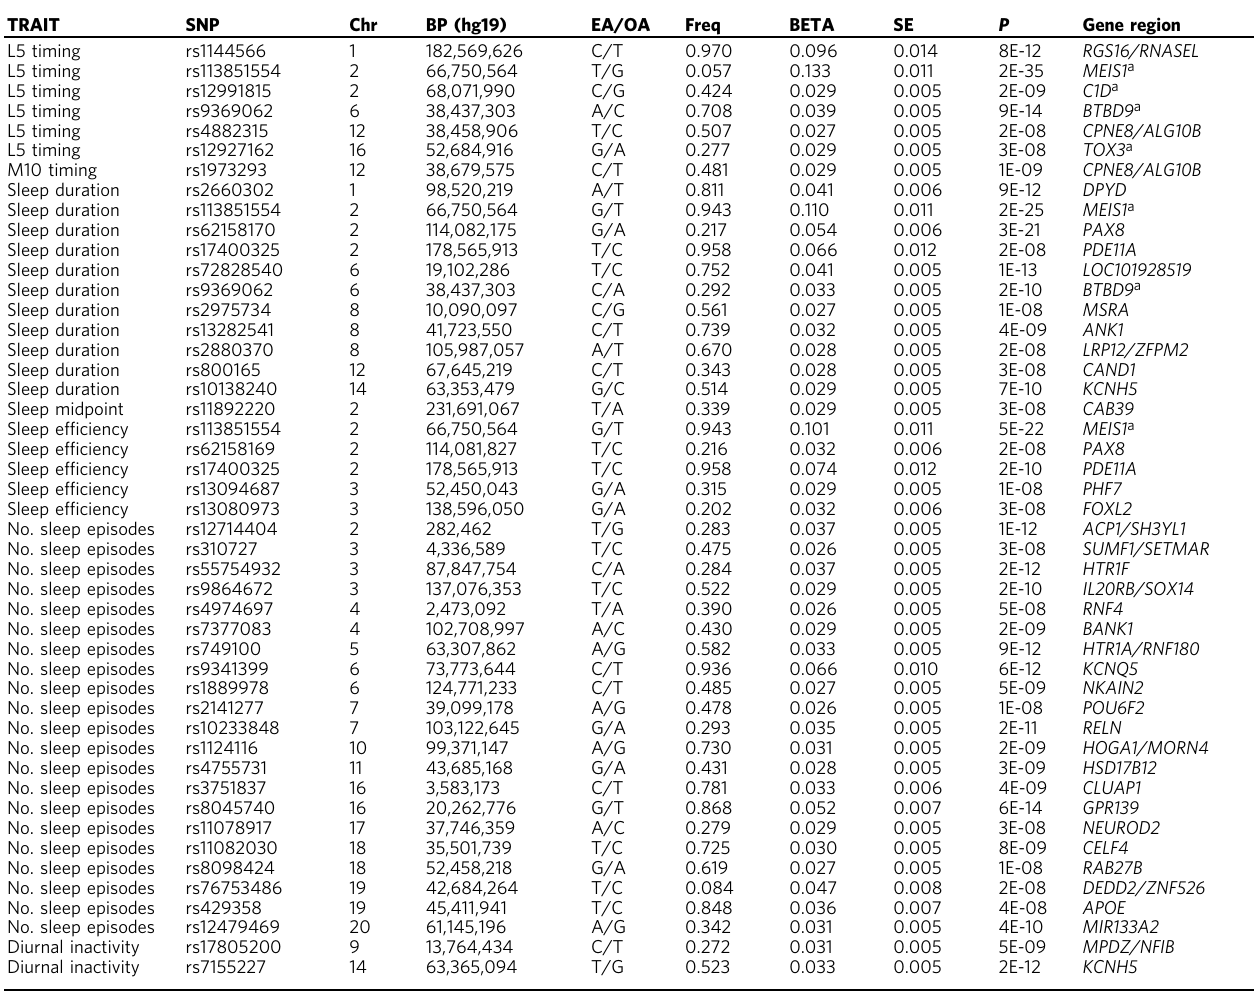
Table 3 Summary statistics for 47 genetic associations identi fi ed in the UK Biobank reaching P < 5 × 10 − 8